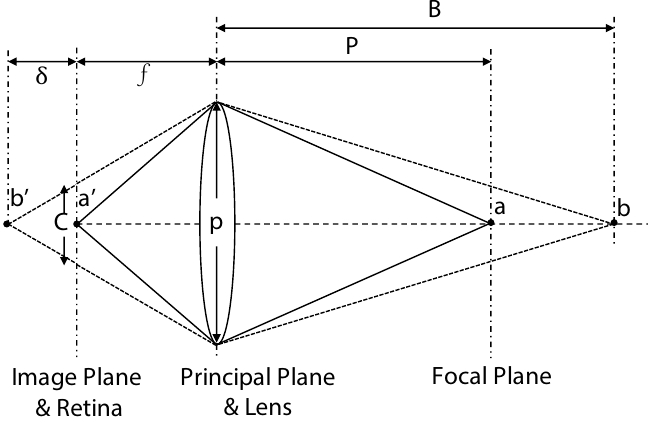
Figure 4. Camera model used in our renderer (adapted from [40,41]). A point a lying on the focal plane, located P away from the eye, appears in focus as a (cid:48) on the retina. Point b , located B away from the lens is focused onto b (cid:48) and is blurred by the CoC, C